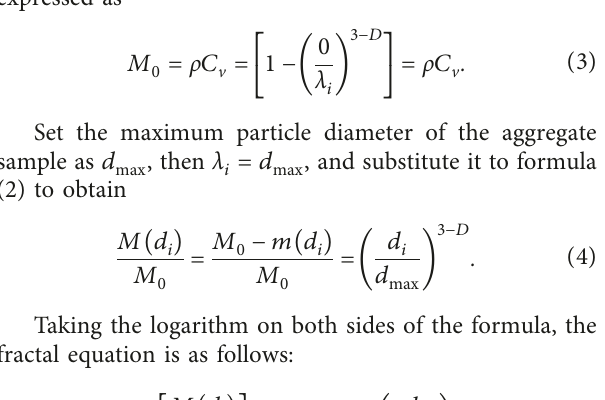
Table 3: Statistical table of crushing and screening of NL13.2 and